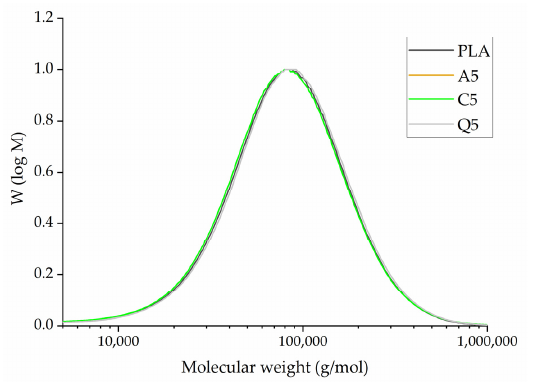
Figure 9. GPC elugram and the Mw, Mn, and PDI of pure PLA and its composites containing 5% ( w / w ) of alizarin (A5), curcumin (C5), or quercetin (Q5). Table 3. Average molecular weights and PDI of PLA and its composites.